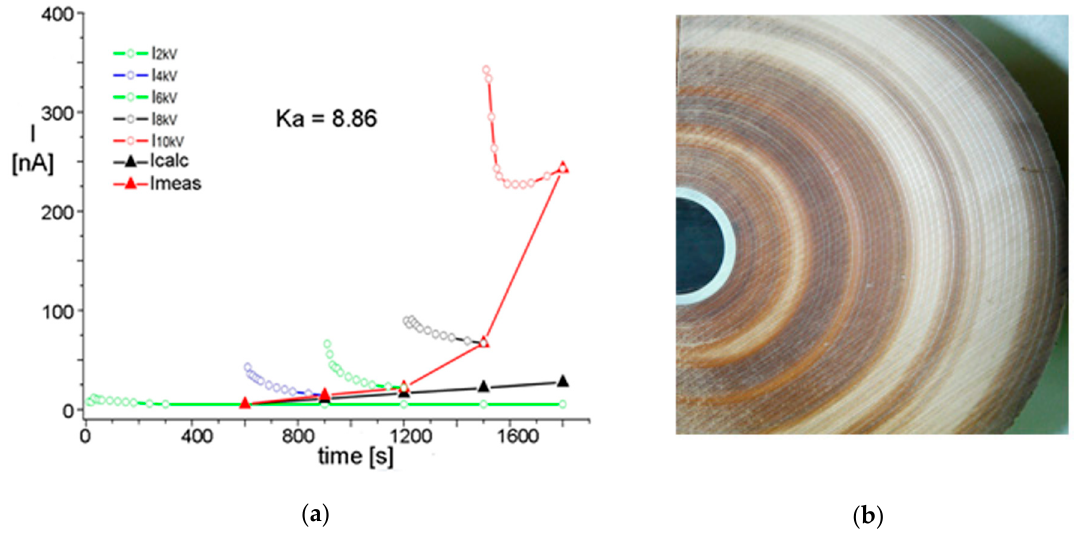
Figure 7. The analysis of the CTF 245 kV (serial number 75D76) bushing: ( a ) SVM test chart; ( b ) cross-section of the core [16].